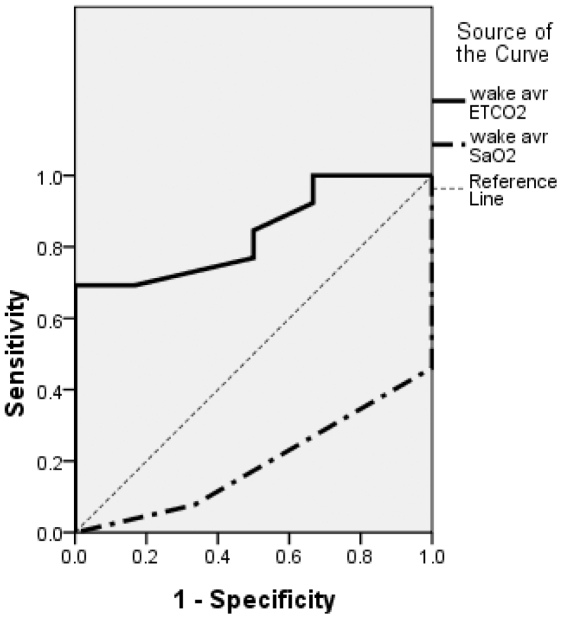
ROC curves for average ETCO2 measured by wake capnography screening and average SaO2 measured by wake pulse oximetry screening as predictors of good compliance with subsequent NIV treatment.The AUC values were 0.840 (95% CI: 0.628–1.000) and 0.192 (95% CI: 0.000–0.389), respectively.